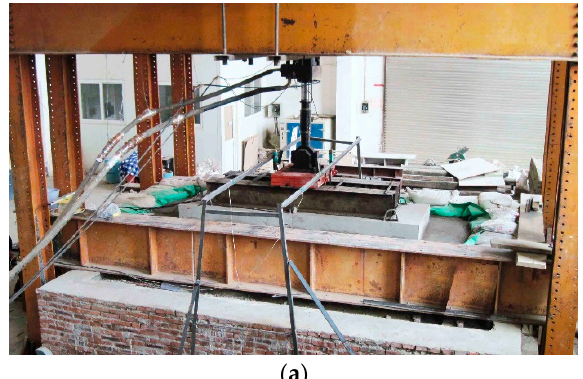
Table 3. Properties of multi-layered soils and